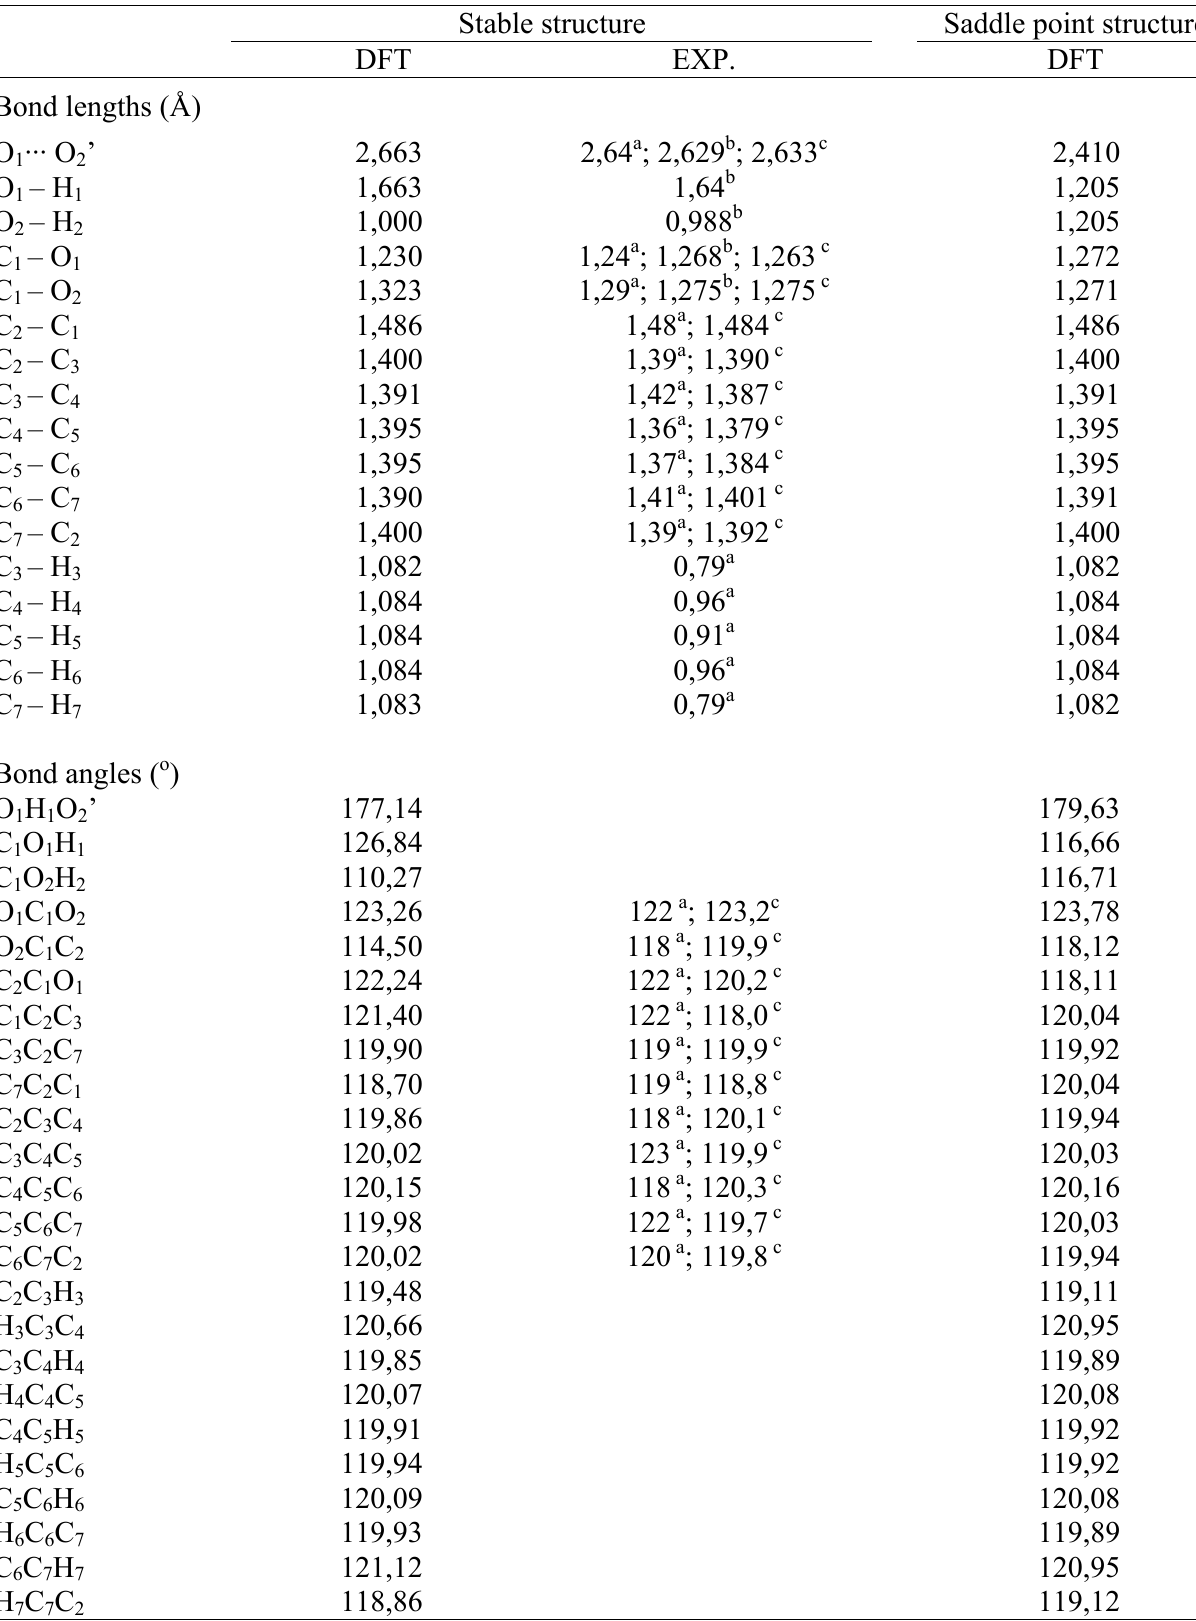
Table 1. Optimized geometries of the stable and saddle point structures of benzoic acid by the B3LYP/6-311++G** (DFT) method. Stable structure Saddle point structure DFT EXP.